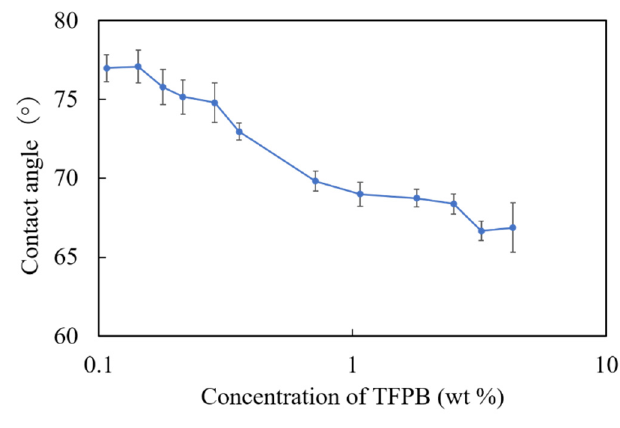
Figure 6. The surface contact angles of TFPB-BBPA-TBAC membranes in different TFPB concen- trations. The results are expressed as means ± SD ( n = 9, 3 membranes × 3 times).